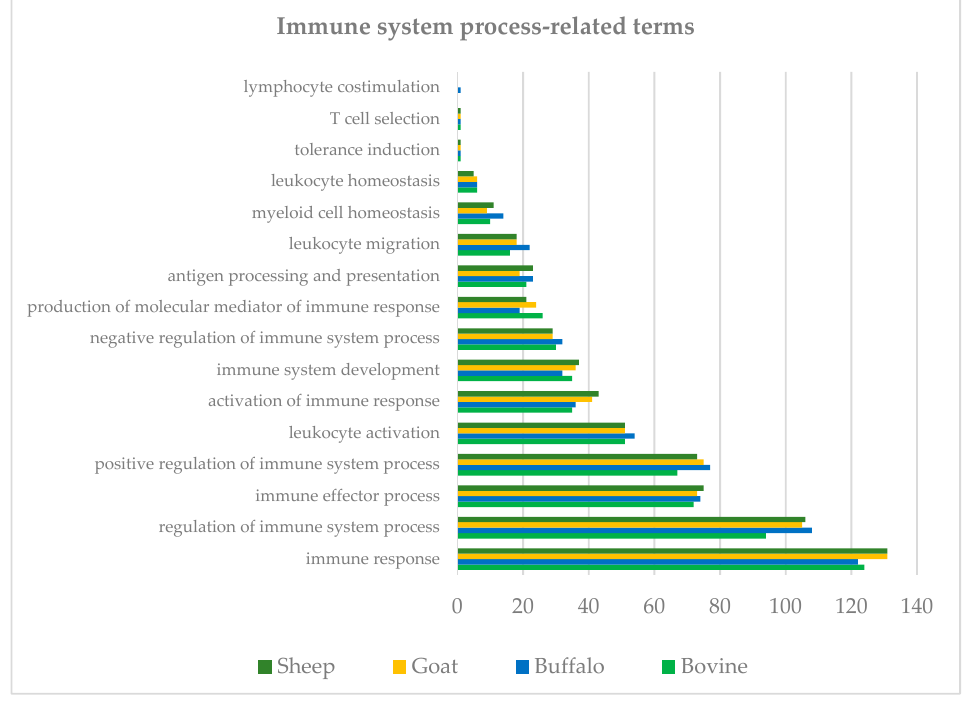
Figure 4. Summary of Biological Process immune system-related terms.